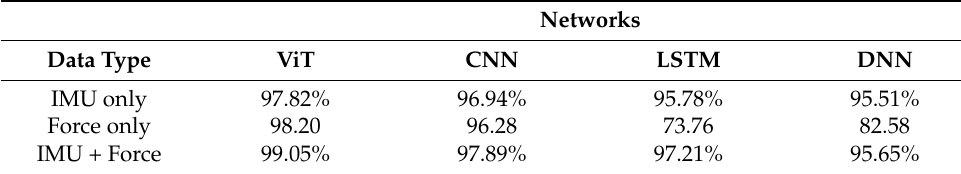
Table 3. Validation accuracy results of the neural network models.